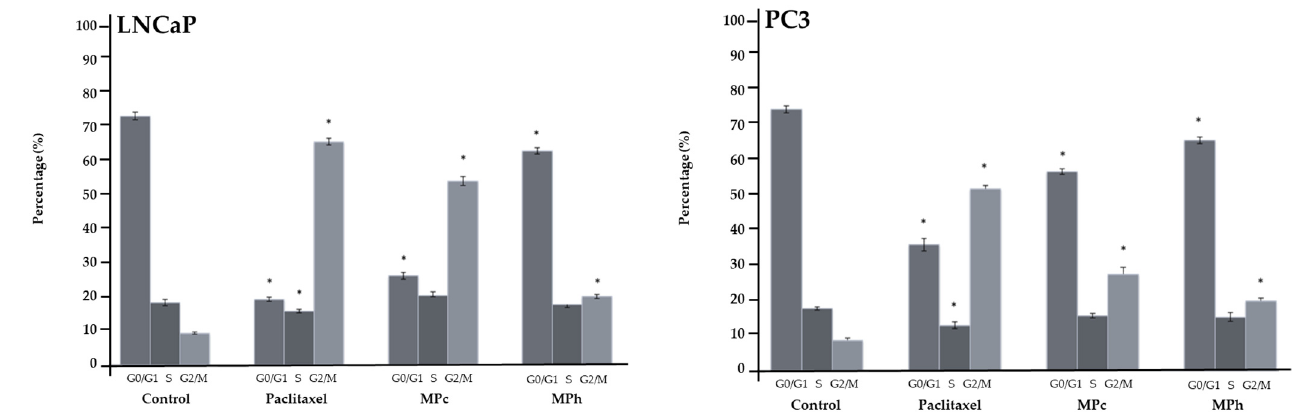
Figure 3. Cell cycle distribution of cell populations (%). LNCaP and PC3 cells were treated for 48 h with the IC50 of the cytotoxic extracts or paclitaxel (positive control). The results shown are representatives of three independent experiments. The error bars display the standard error of the mean (SEM) obtained from 3 independent experiments. Significance compared to control, * ( p < 0.05) as determined via unpaired t -test.